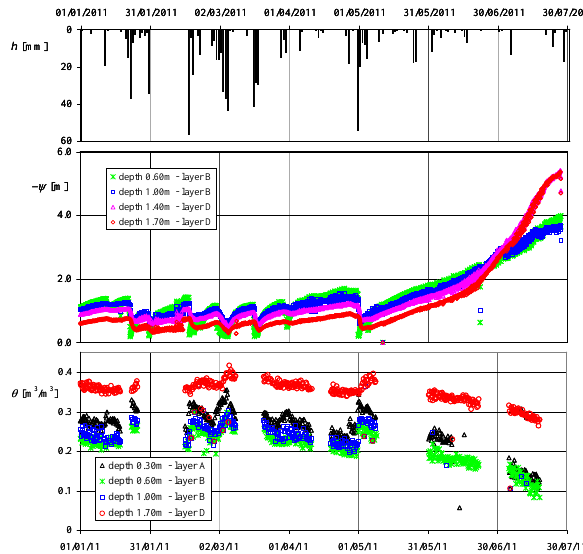
Fig. 2. Field monitoring data observed at various depths between Figure 2 1 January 2011 and 20 July 2011. From top to bottom: daily rainfall height; soil suction; soil volumetric water